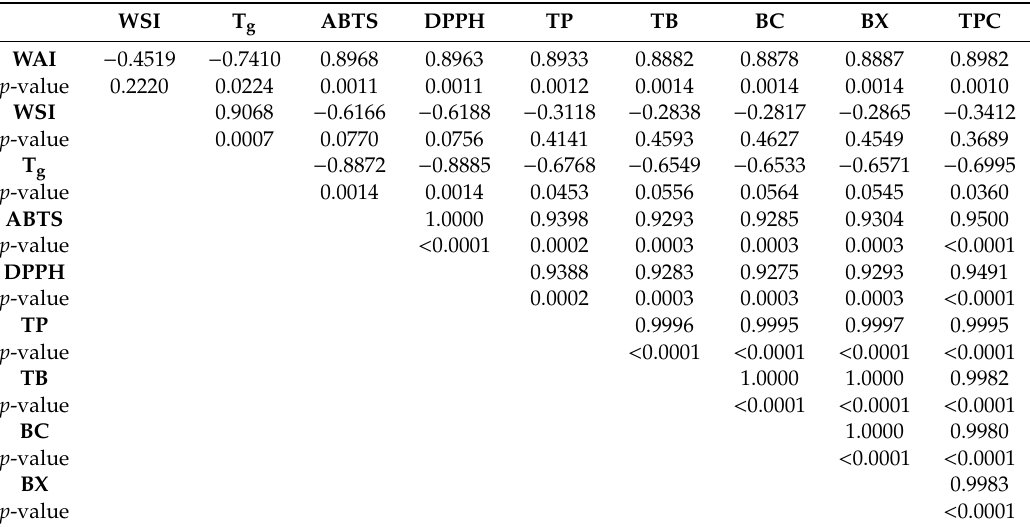
Table 2. Correlation coe ffi cient and the level of significance ( p -value) between the response variables of encapsulated freeze-dried beet extracts ( Beta vulgaris